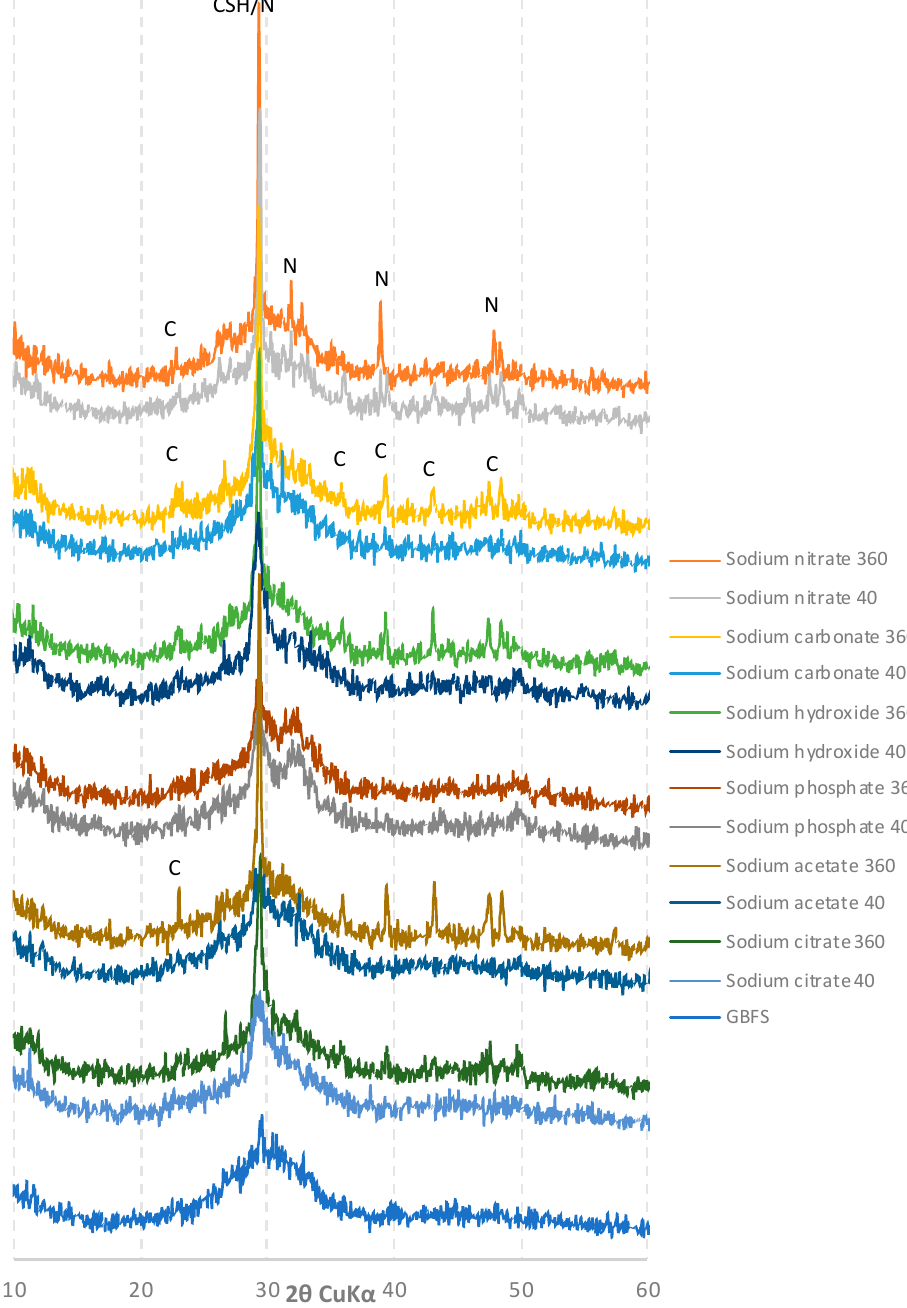
Figure 7. Diffractograms of slag activated with sodium nitrate, carbonate, hydroxide, phosphate, acetate and citrate after 40 and 360 days of curing: CSH —calcium silicate hydrates; N —sodium nitrate; C —calcite.